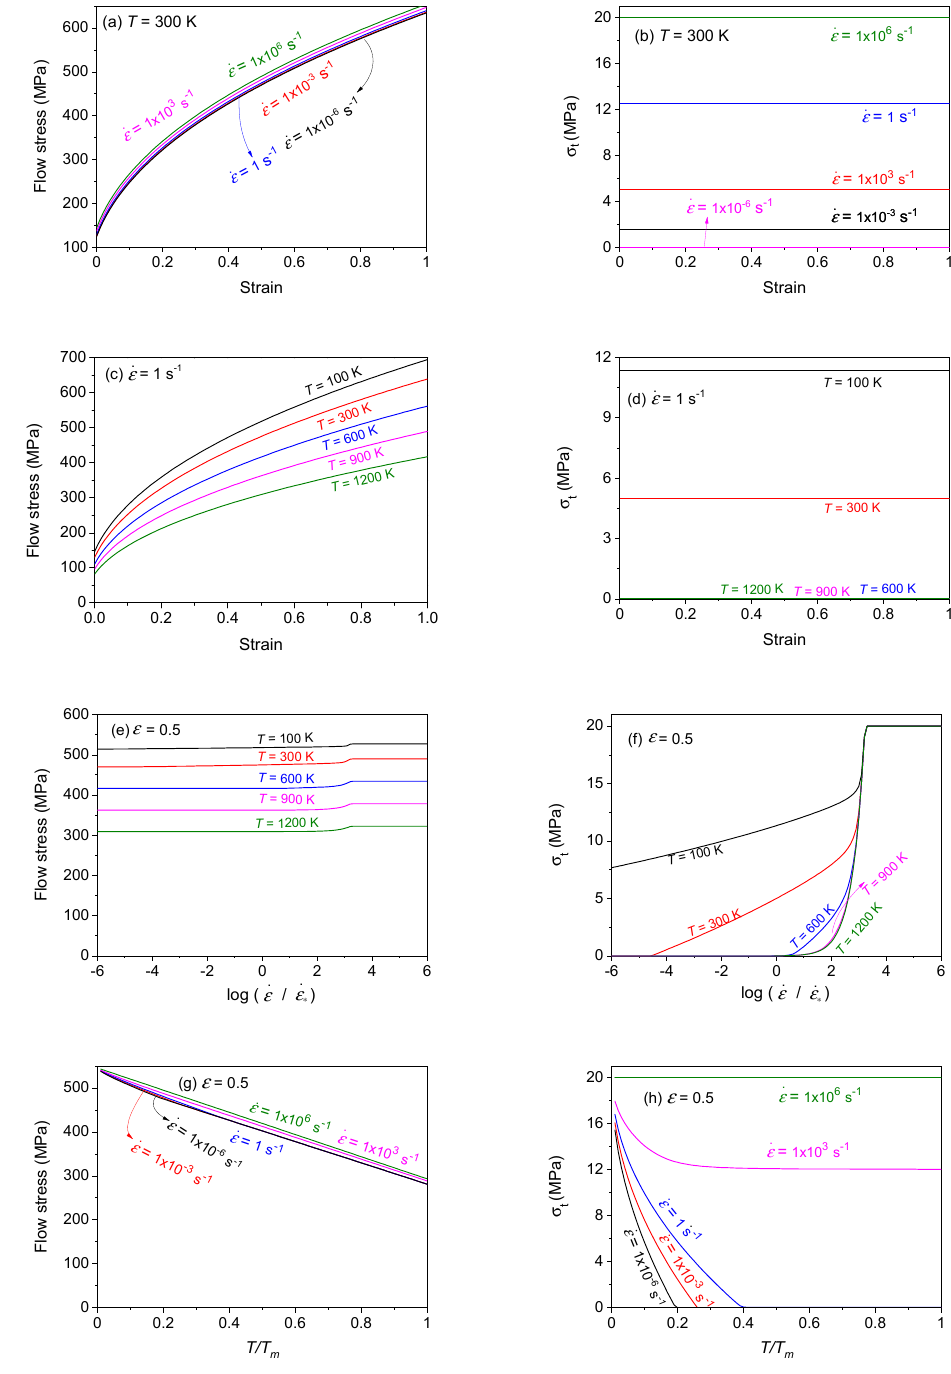
Figure 23. ( a ) σ vs. ε and ( b ) σ t vs. ε curves predicted for copper at 300 K for different strain rates Figure 23. ( a ) 𝜎 vs. 𝜀 and ( b ) 𝜎 (cid:2930) vs. 𝜀 curves predicted for copper at 300 K for different strain . rates using the SCGL model. ( c ) 𝜎 vs. 𝜀 and ( d ) 𝜎 (cid:2930) vs. 𝜀 curves at 𝜀(cid:4662) = 1 for different tempera- ε = 1 for different temperatures. ( e ) σ vs. using the SCGL model. ( c ) σ vs. ε and ( d ) σ t vs. ε curves at . . . . tures. ( e ) 𝜎 vs. log ( 𝜀(cid:4662) / 𝜀(cid:4662) ∗ ) and ( f ) 𝜎 (cid:2930) vs. log ( 𝜀(cid:4662) / 𝜀(cid:4662) ∗ ) curves for different temperatures at 𝜀 = 0.5. ( g ) 𝜎 ε / ε ∗ ) and ( f ) σ t vs. log ( ε / ε ∗ ) curves for different temperatures at ε = 0.5. ( g ) σ vs. T / T m and log ( . vs. T / T m and ( h ) 𝜎 (cid:3047) vs. T / T m curves for different strain rates at 𝜀 = 0.5. 𝜀(cid:4662) ∗ = 1 s − 1 and T m = 1356 K. ε ∗ = 1 s − 1 and T m = 1356 ( h ) σ t vs. T / T m curves for different strain rates at ε = 0.5. Figure 23b plots the strain independent nature of 𝜎 (cid:2930) , which is governed by Equation (49). It also indicates that the strain rate dependent variation of 𝜎 (cid:2930) is at best 20 MPa. Fig- ure 23c illustrates the temperature dependence of the stress–strain curves at 𝜀(cid:4662) = 1 s − 1 . A notable temperature dependence is observed, which results from the temperature de-